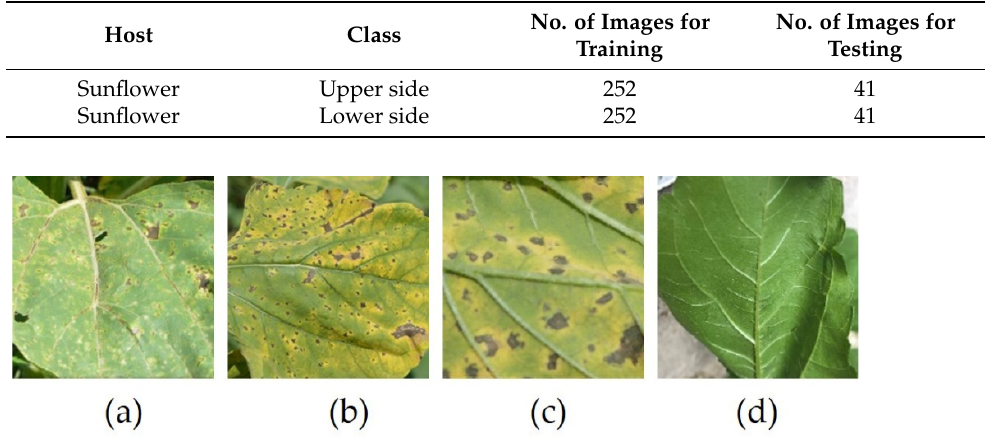
Figure 2. Images from the dataset. ( a ) Upper; ( b ) Upper; ( c ) Lower; ( d )